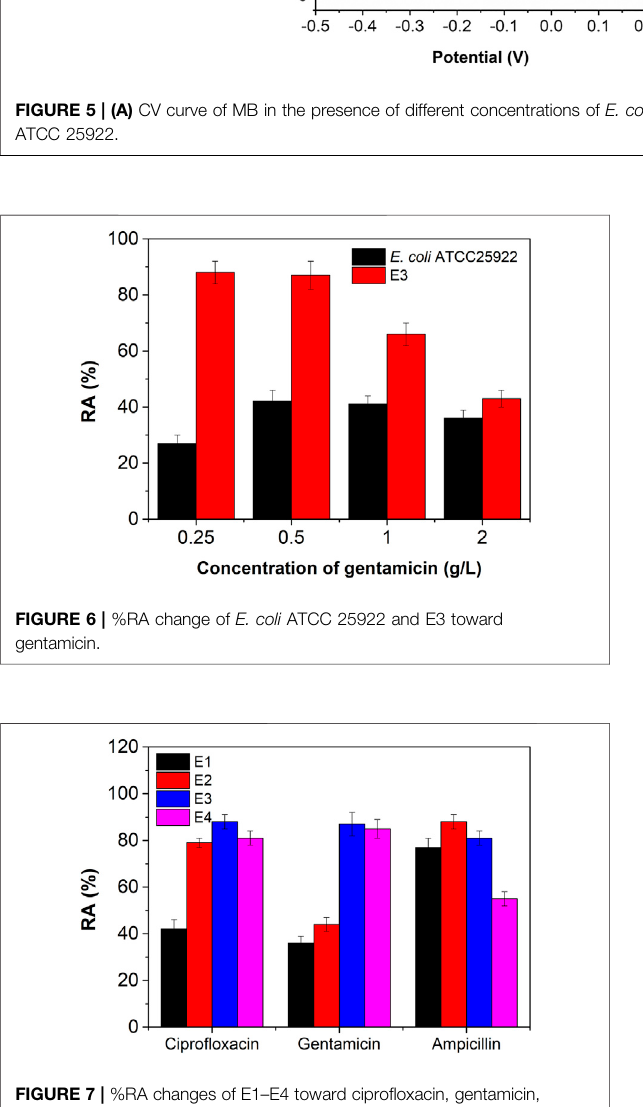
Frontiers in Chemistry |